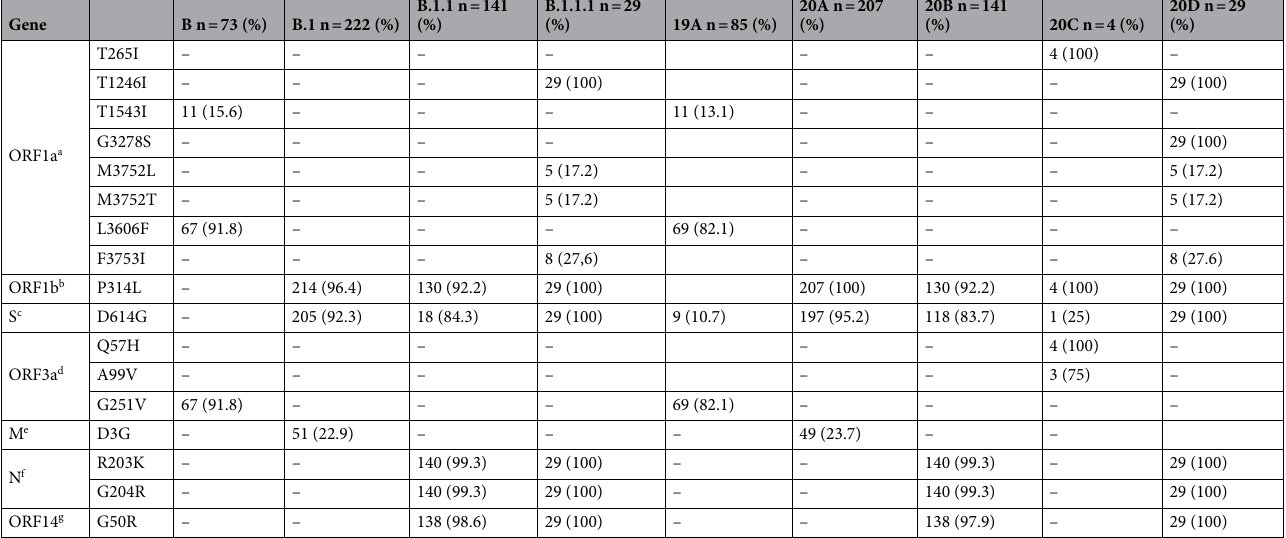
Table 2. Aminoacid substitutions found in more than 10% of sequences stratified according to lineage and clade. a Open Reading Frames 1a. b Open Reading Frames 1b. c Spike gene. d Open Reading Frames 3a. e Membrane gene. f Nucleocapsid gene. g Open Reading Frames